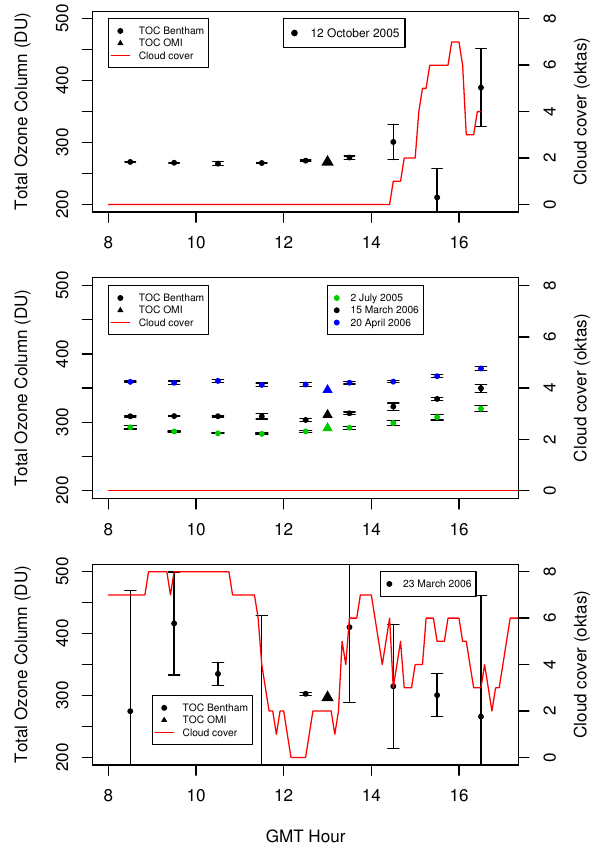
Fig. 3. Diurnal evolution of the total ozone column and the cloud cover characterized in oktas (eighths of sky) for the days 12 Octo- ber 2005 (top), 2 July 2005, 15 March 2006 and 20 April 2006 (mid- dle), and 23 March 2006 (bottom). The error bars represent the stan- dard deviation (SD) of the hourly total ozone averages. The punctual daily total ozone data derived from the satellite Ozone Monitoring Instrument have been also included in the plots. DU, Dobson